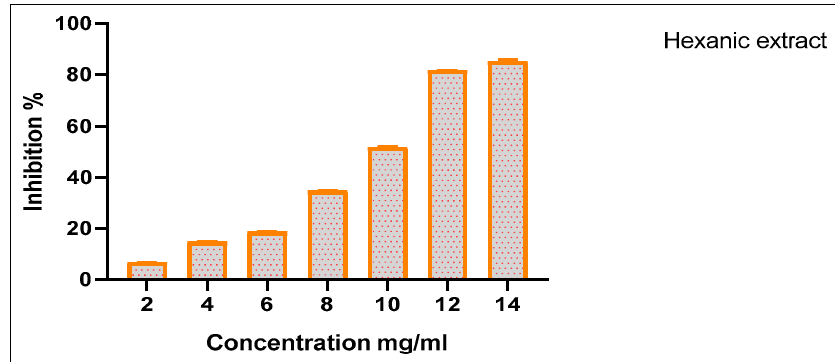
Figure 4. Scavenging activity of C. colocynthis hexane extract using DPPH assay.